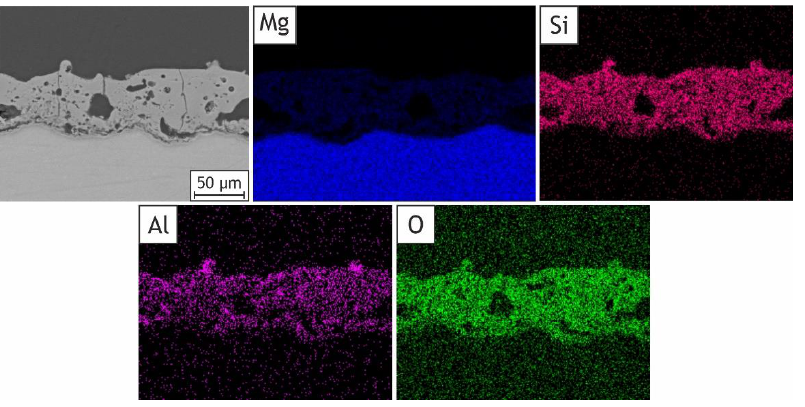
Figure 8. SEM image and EDS maps of elements distribution for the cross section of H40 sample: Mg, Si, Al, O.